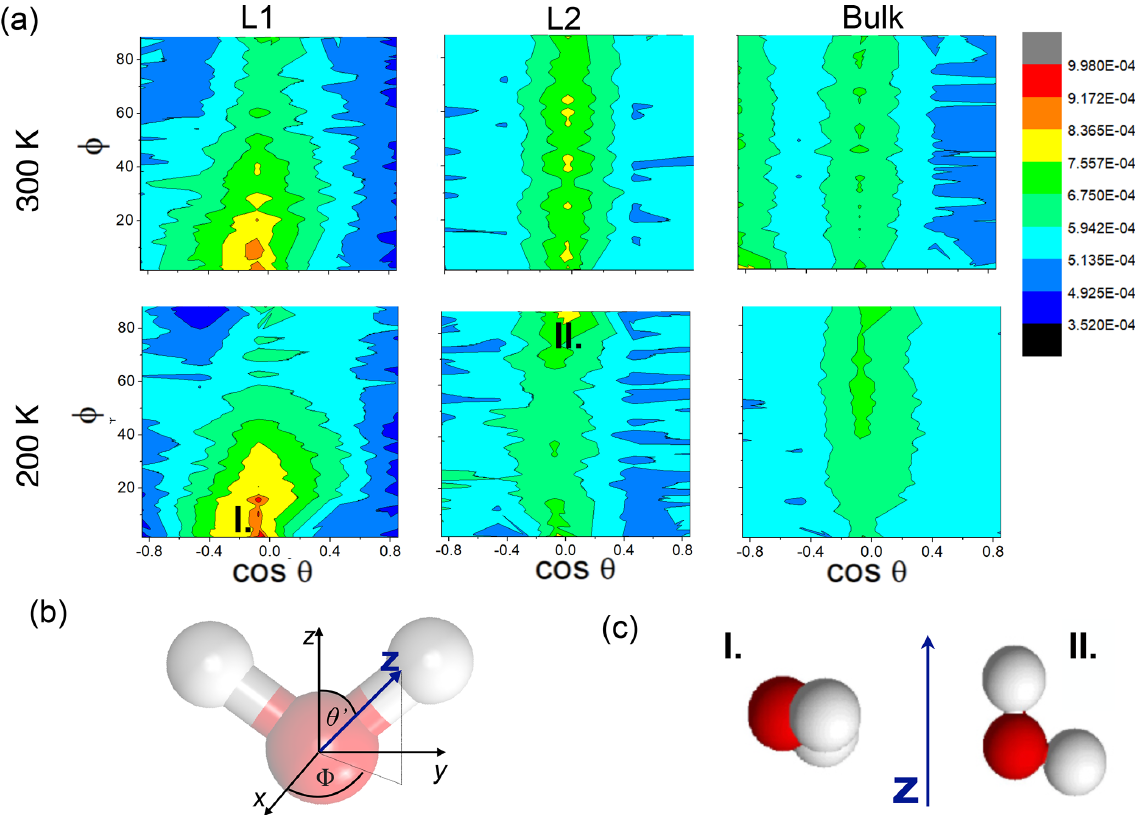
Figure B5. (a) Orientational maps of the water molecules in the first (L1) and second (L2) molecular layer and the bulk phase. (b) The definition of θ (cid:48) and φ in the Cartesian frame centered on a water molecule. (c) Examples of the two main